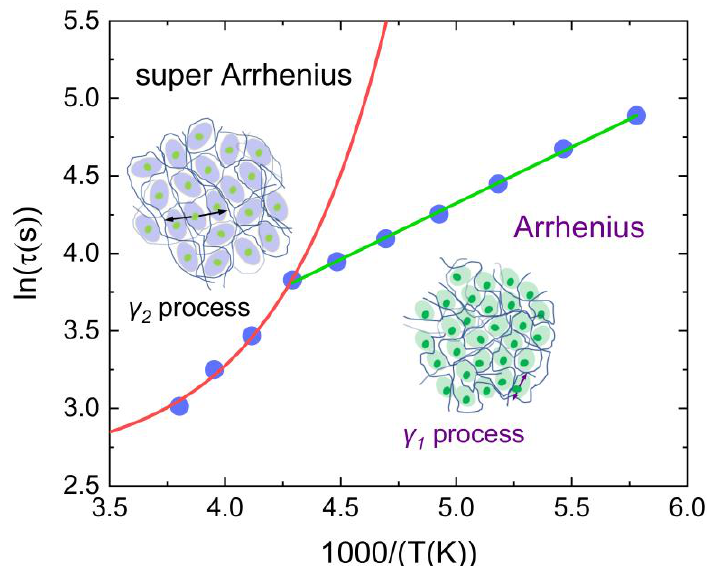
Figure 3. Schematic representation of temperature dependence for relaxation times. The small green ellipse on the right represents the local motion of the partial segment of the disordered side chain; the light green area is the γ 1 relaxation region; the purple arrows represent the non-cooperative rearrangement of the local segment of the disordered side chain; the green line represents the γ 1 relaxation disordered of the side chains of PBTTT following the Arrhenius temperature dependence. The little green ellipses on the left represent the local motion of the partial segments of the disordered side chains; the light blue area represents the γ 2 relaxation region; the black arrows among the light blue ellipses represent the cooperative motion of partial segments of the disordered side chains; the red line represents the γ 2 relaxation of the disordered side chains follows the supper Arrhenius temperature dependence. The dark blue curves represent the main chains of PBTTT.